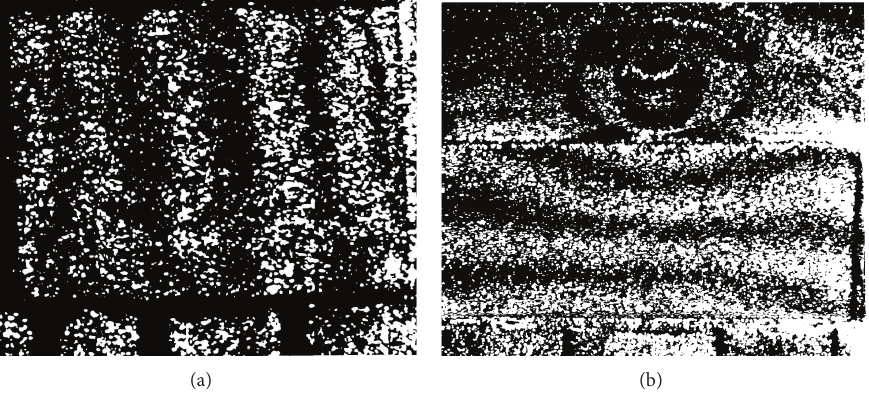
Figure 5: Correlation fringes: (a) horizontal displacement; (b) vertical displacement.